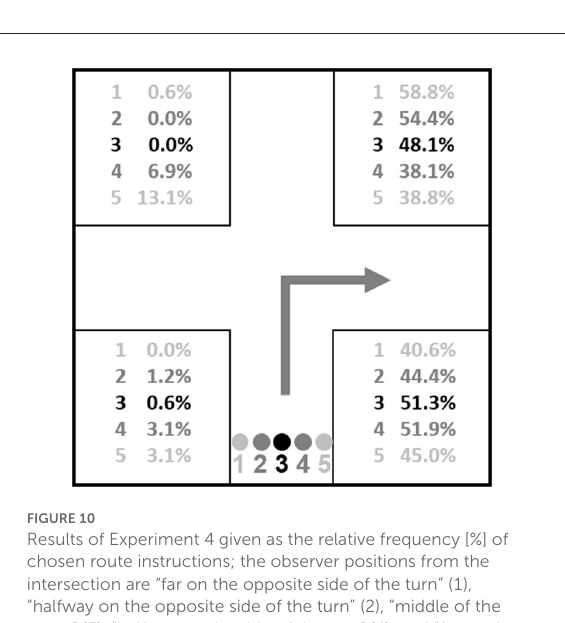
FIGURE10 Results of Experiment 4 given as the relative frequency [%] of chosen route instructions; the observer positions from the intersection are “far on the opposite side of the turn” (1), “halfway on the opposite side of the turn” (2), “middle of the street” (3), “halfway on the side of the turn” (4), and “far on the side of the turn” (5); the landmark positions are: “side of the turn, before the intersection” [ (bottom right) ; M ∼ 46.6%]; “side of the turn, behind the intersection” [ (top right) ; M ∼ 47.6%]; “opposite side of the turn, behind the intersection” [ (top left) ; M ∼ 4.1%]; “opposite side of the turn, before the intersection” [ (bottom left) ; M ∼